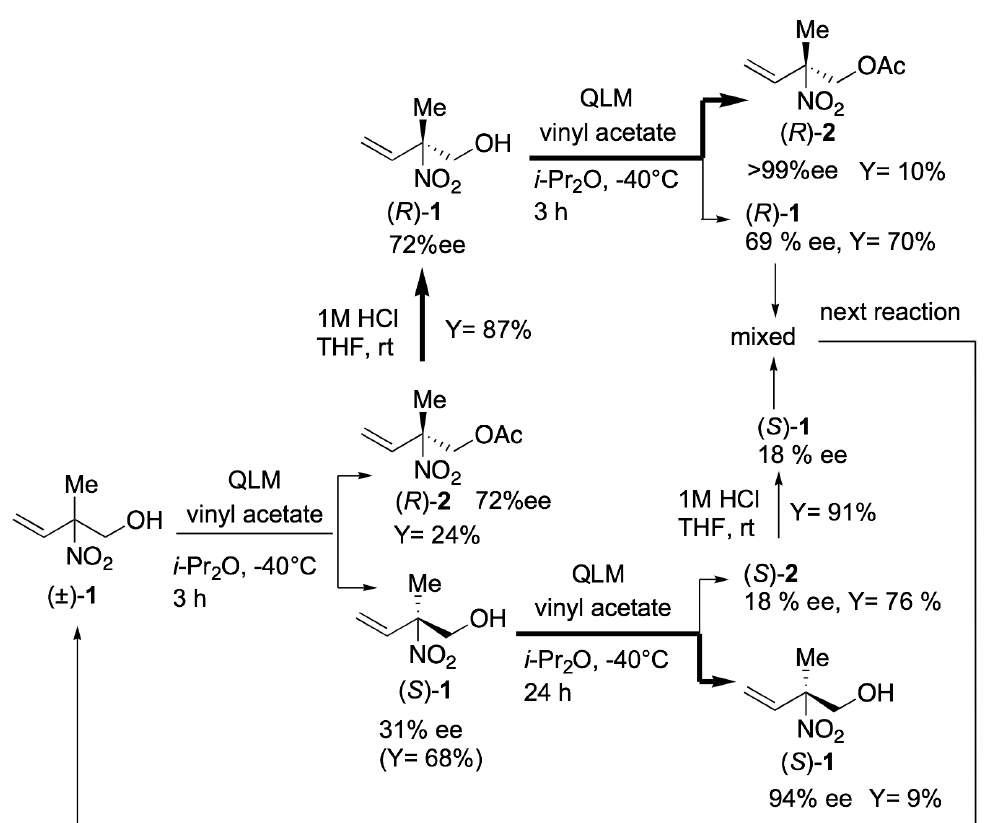
Scheme 3. Protocol of preparation of chiral 1 using “low-temperature lipase-catalyzed